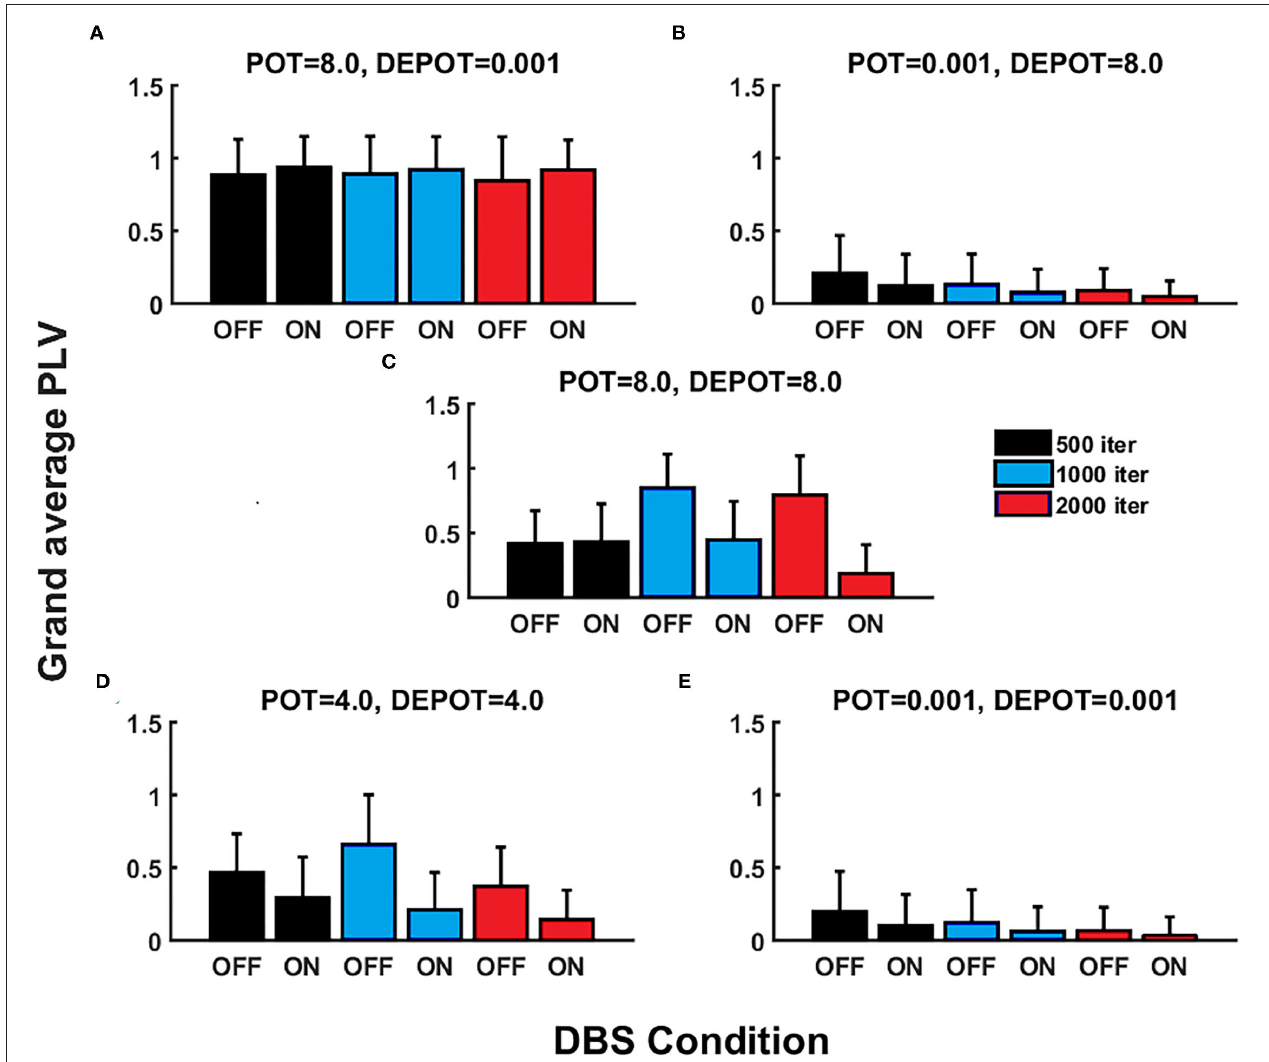
FIGURE 3 | The simulation results (mean and SD of the grand average PLV) corresponding to the influence of stimulation duration (500, 1,000, and 2,000 iterations) in de novo DBS “patients”: unbalanced potentiation and depotentiation (high and low level) (A,B) ; balance potentiation and depotentiation, i.e., equally high levels, (C) ; equally medium levels (D) ; and equally low levels (E)